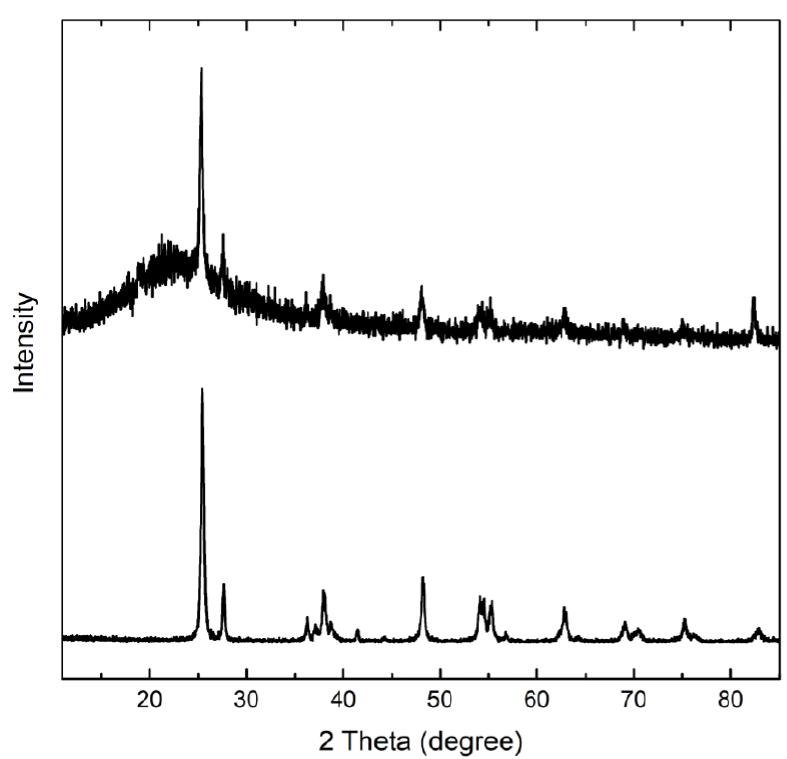
Figure 2. Powder X-ray diffraction patterns of C/TiO 2 -Dots (upper) and the precursor TiO 2 nanopar- ticles (lower) from the commercially acquired Degussa